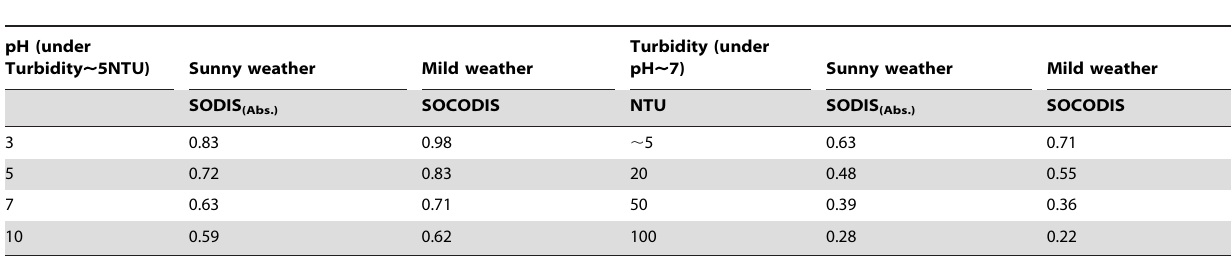
Table 3. Comparison of k max (1/min) for P. aeruginosa disinfection between SODIS (Abs.) (suny weather) and SOCODIS system (mild weather) at different pH and turbidity